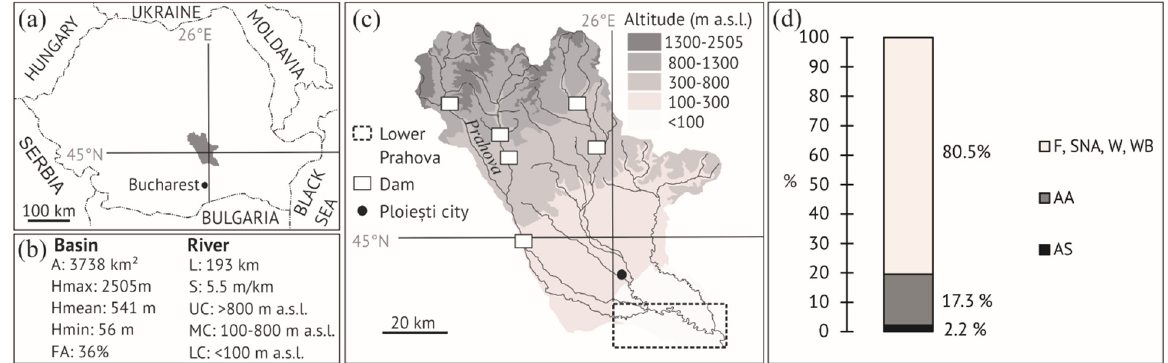
Figure 1. The study area and its features. ( a ) Location of the Prahova River basin in Romania; ( b ) Main morphometric characteristics of the Prahova River and basin [23]; ( c ) Location of the Lower Prahova River as studied river sector; ( d ) Land use in the Prahova River basin according to Corine Land Cover database